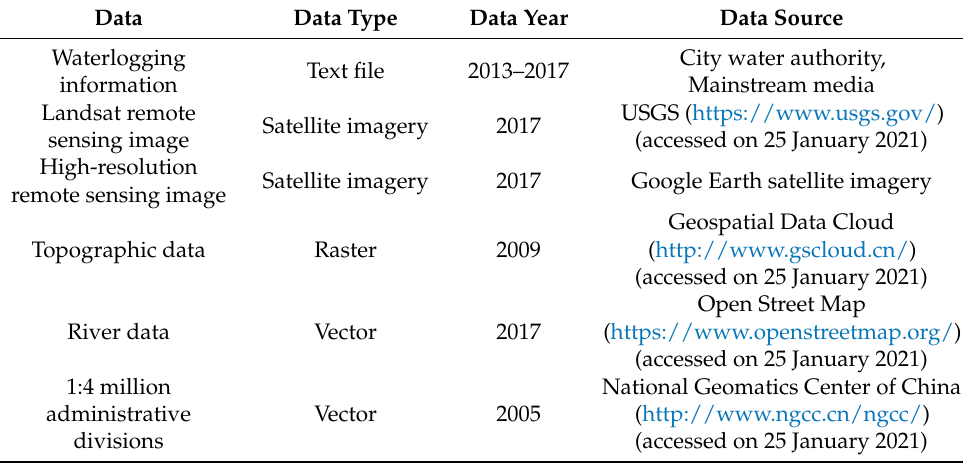
Table 1. Metadata information.